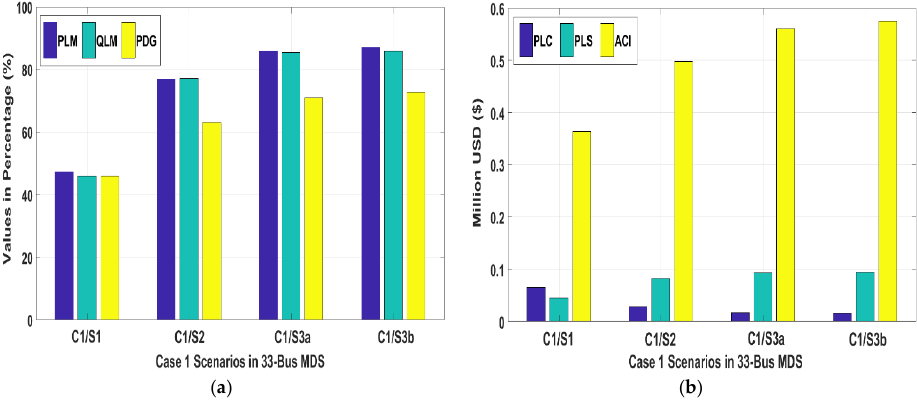
Figure 9. Case 1 Scenarios for 33-bus MDS (U_Max) ( a ) Performance evaluation in-terms of PLM , QLM and PDG ; ( b ) Performance evaluation in-terms of PLC , PLS and ACI .